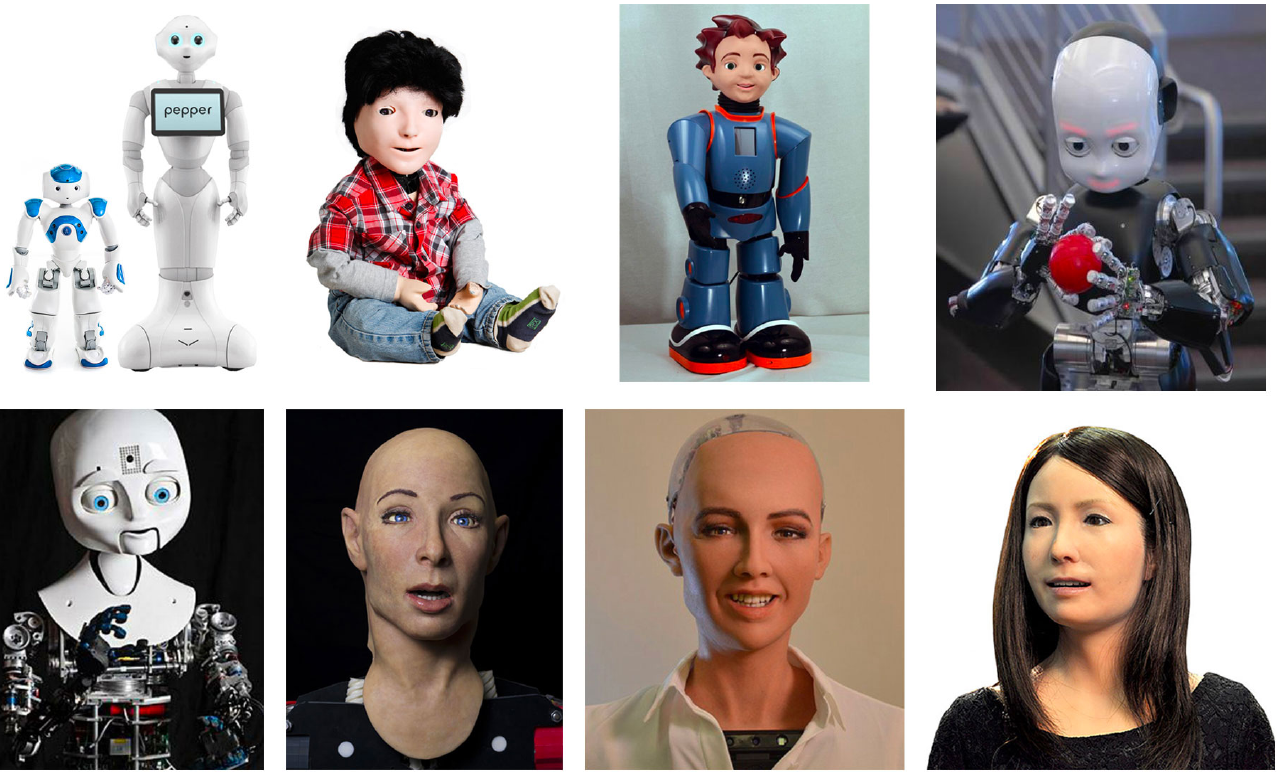
Figure 1. Pictures of anthropomorphic robots with different levels of human-likeness and expressive capabilities. Top row: Nao [25] and Pepper [26]; Kaspar [27]; Zeno [28]; iCub [29]; Bottom row: Nexi [30]; Face [5]; Sophia [31]; GeminoidF